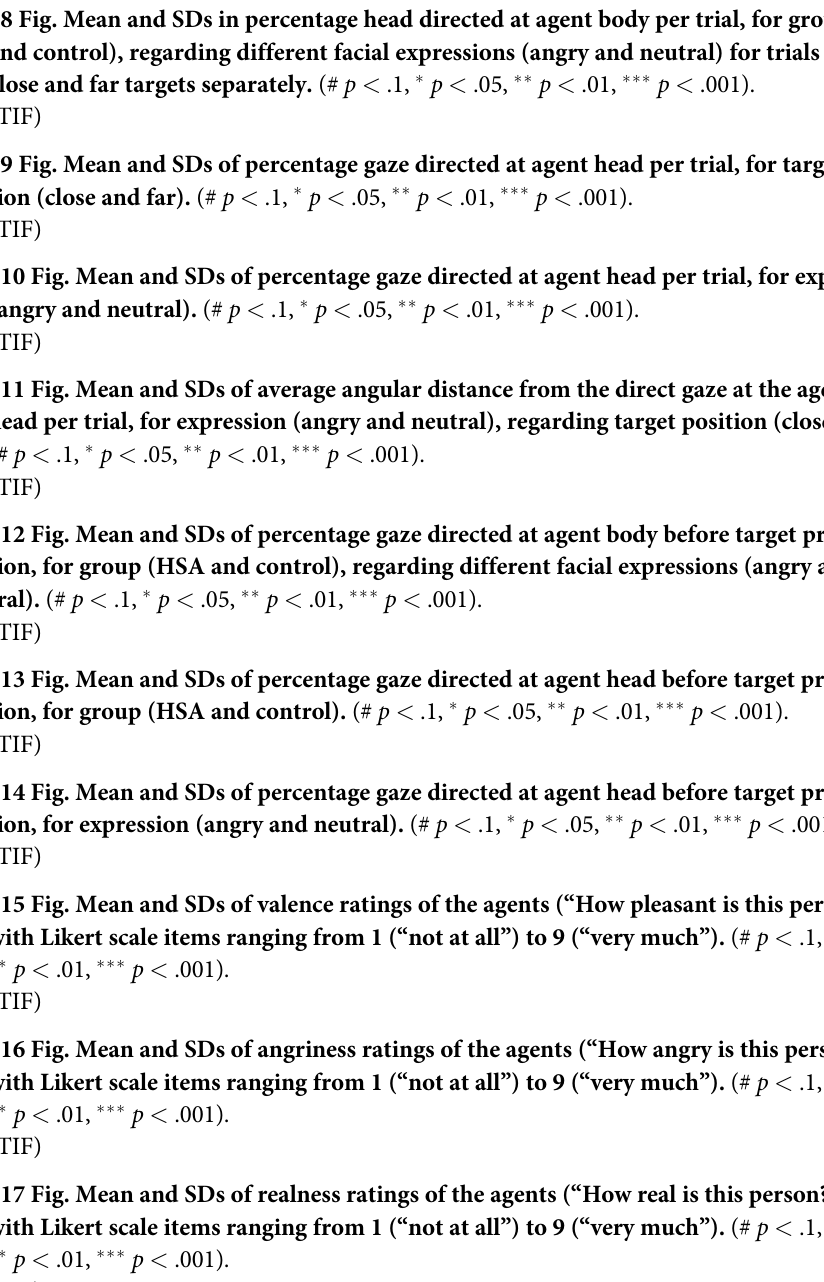
S8 Fig. Mean and SDs in percentage head directed at agent body per trial, for group (HSA and control), regarding different facial expressions (angry and neutral) for trials with close and far targets separately. (# p < .1, � p < .05, �� p < .01, ��� p < .001). (TIF) S9 Fig. Mean and SDs of percentage gaze directed at agent head per trial, for target posi- tion (close and far). (# p < .1, � p < .05, �� p < .01, ��� p < .001). (TIF) S10 Fig. Mean and SDs of percentage gaze directed at agent head per trial, for expression (angry and neutral). (# p < .1, � p < .05, �� p < .01, ��� p < .001). S11 Fig. Mean and SDs of average angular distance from the direct gaze at the agents’ head per trial, for expression (angry and neutral), regarding target position (close and far).